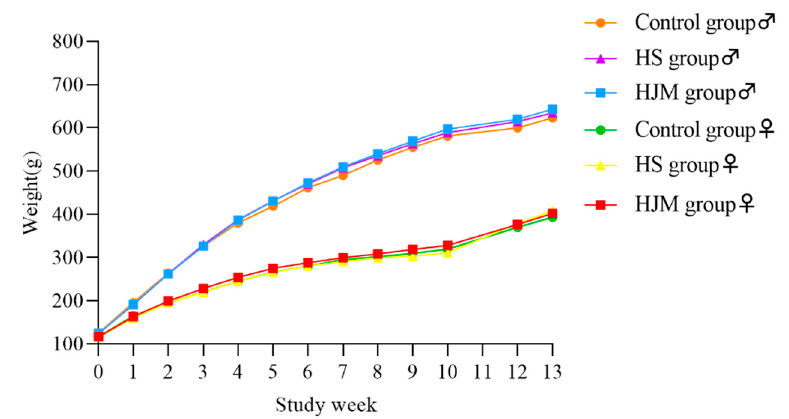
Figure 2. Mean weekly body weight of male and female rats.